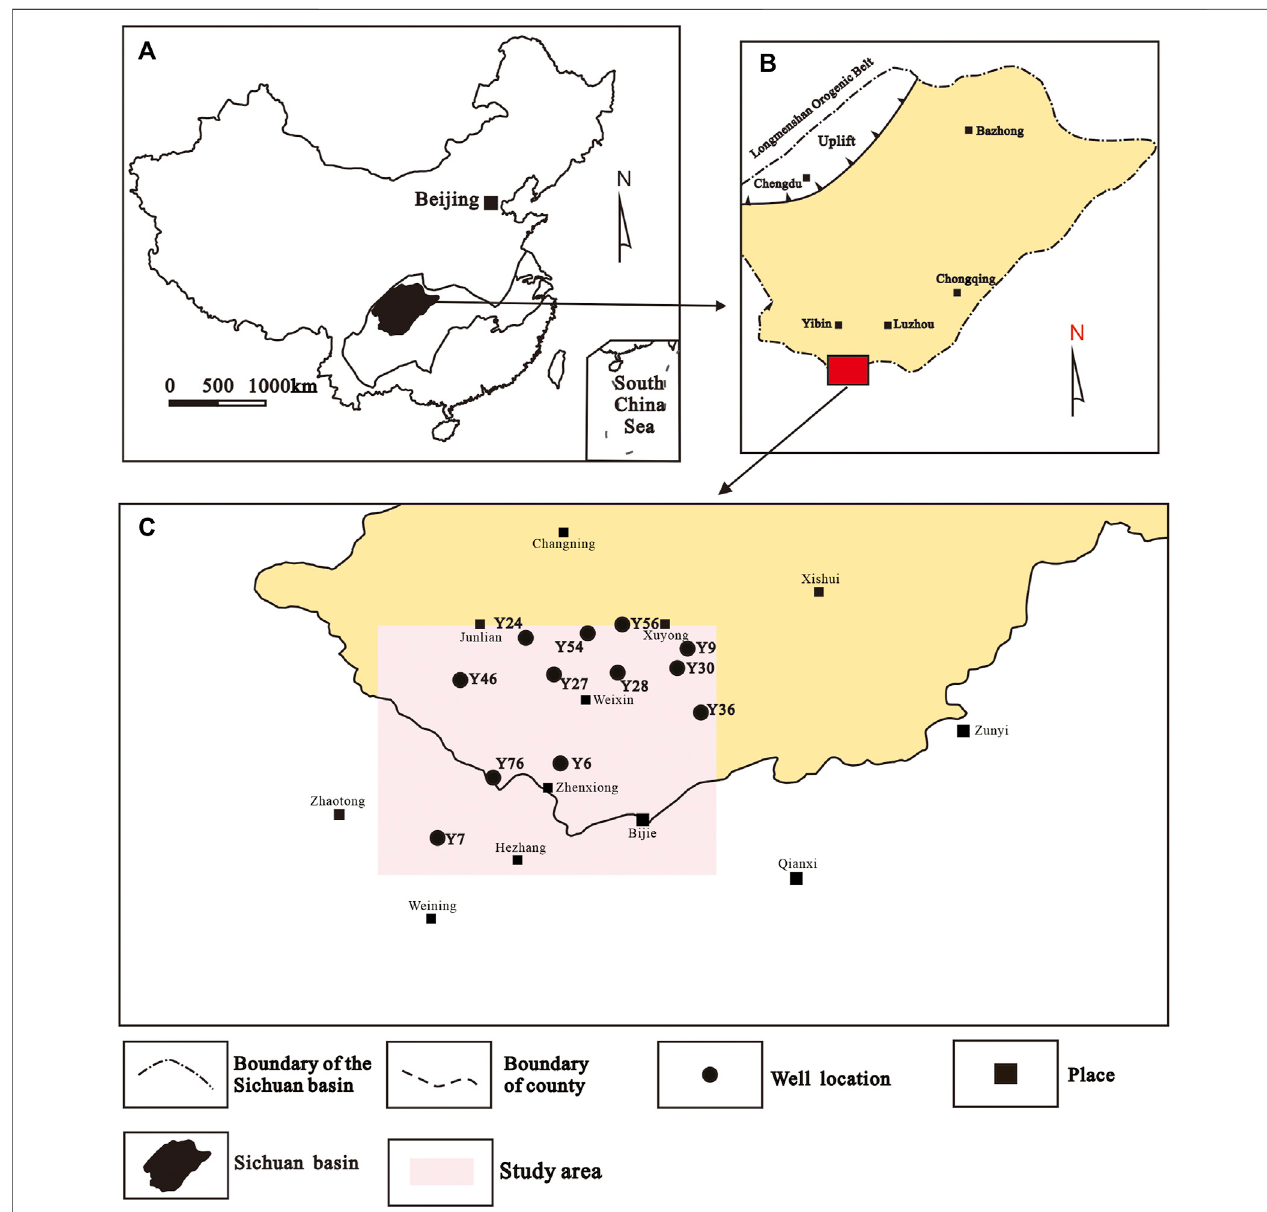
FIGURE 1 | Schematic diagram of the study area. (A) Tectonic location of the Sichuan Basin within China. (B) Location of the study area in the Sichuan Basin. (C) Distribution of the study wells.